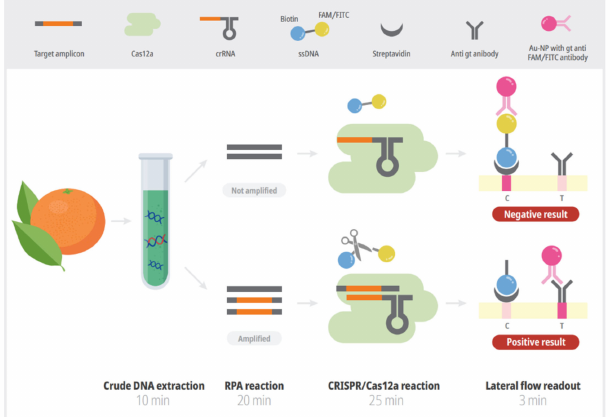
Figure 1. Schematic of the simple and rapid citrus scab detection process using the RPA- CRISPR/Cas12a-LFA assay. Unique genomic regions of Elsinoë fawcettii were amplified in an RPA reaction in 20 min at 37 ◦ C, using crude DNA extract. The amplification product was added into a CRISPR/Cas12a mixture, and a trans-cleavage reaction was activated in the presence of the target amplicon and was completed in 25 min at 37 ◦ C. The result was visible in 3 min using lateral flow readout. Without target amplicon, the intact ssDNA is captured in C line and then gold nanoparticle is trapped in the C line which refers negative result. With target amplicon, the labels are separated from each other by activated Cas12a and gold nanoparticle is trapped in the T line which refers positive result. ssDNA: single stranded DNA, streptavidin: biotin-binding protein, gt: goat, Au-NP: gold conjugated nanoparticle, C: control line, T: test line.